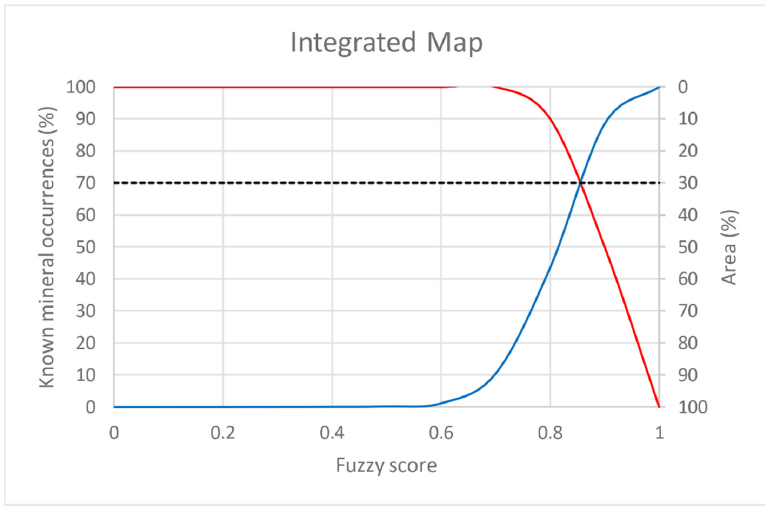
Figure 16. P-A plot of the integrated map obtained using fuzzy gamma operator (gamma = 0.9). Remote Sens. 2020 , 12 , x FOR PEER REVIEW